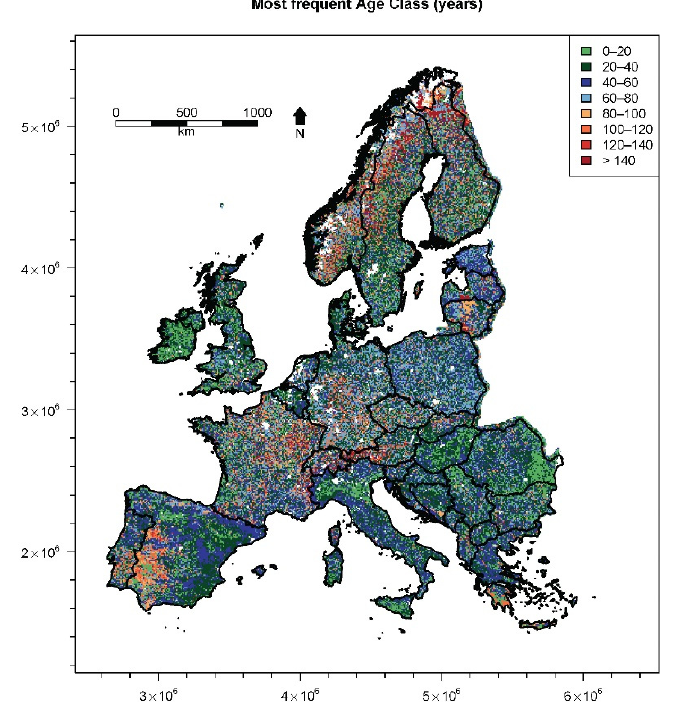
Figure 5. Map showing the most frequent age class for vegetated 8 × 8 km cells. For details, see Figure 3.